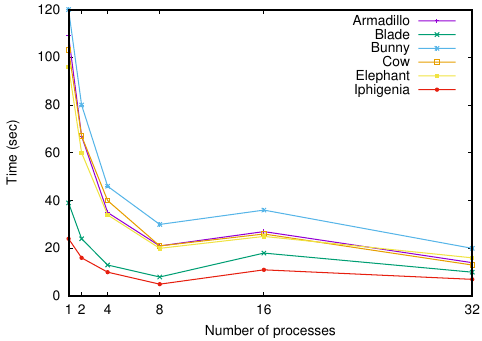
Figure 11. Comparison of global computation time (in seconds) to compute the same final hexahedral subdivision, for increasing number of